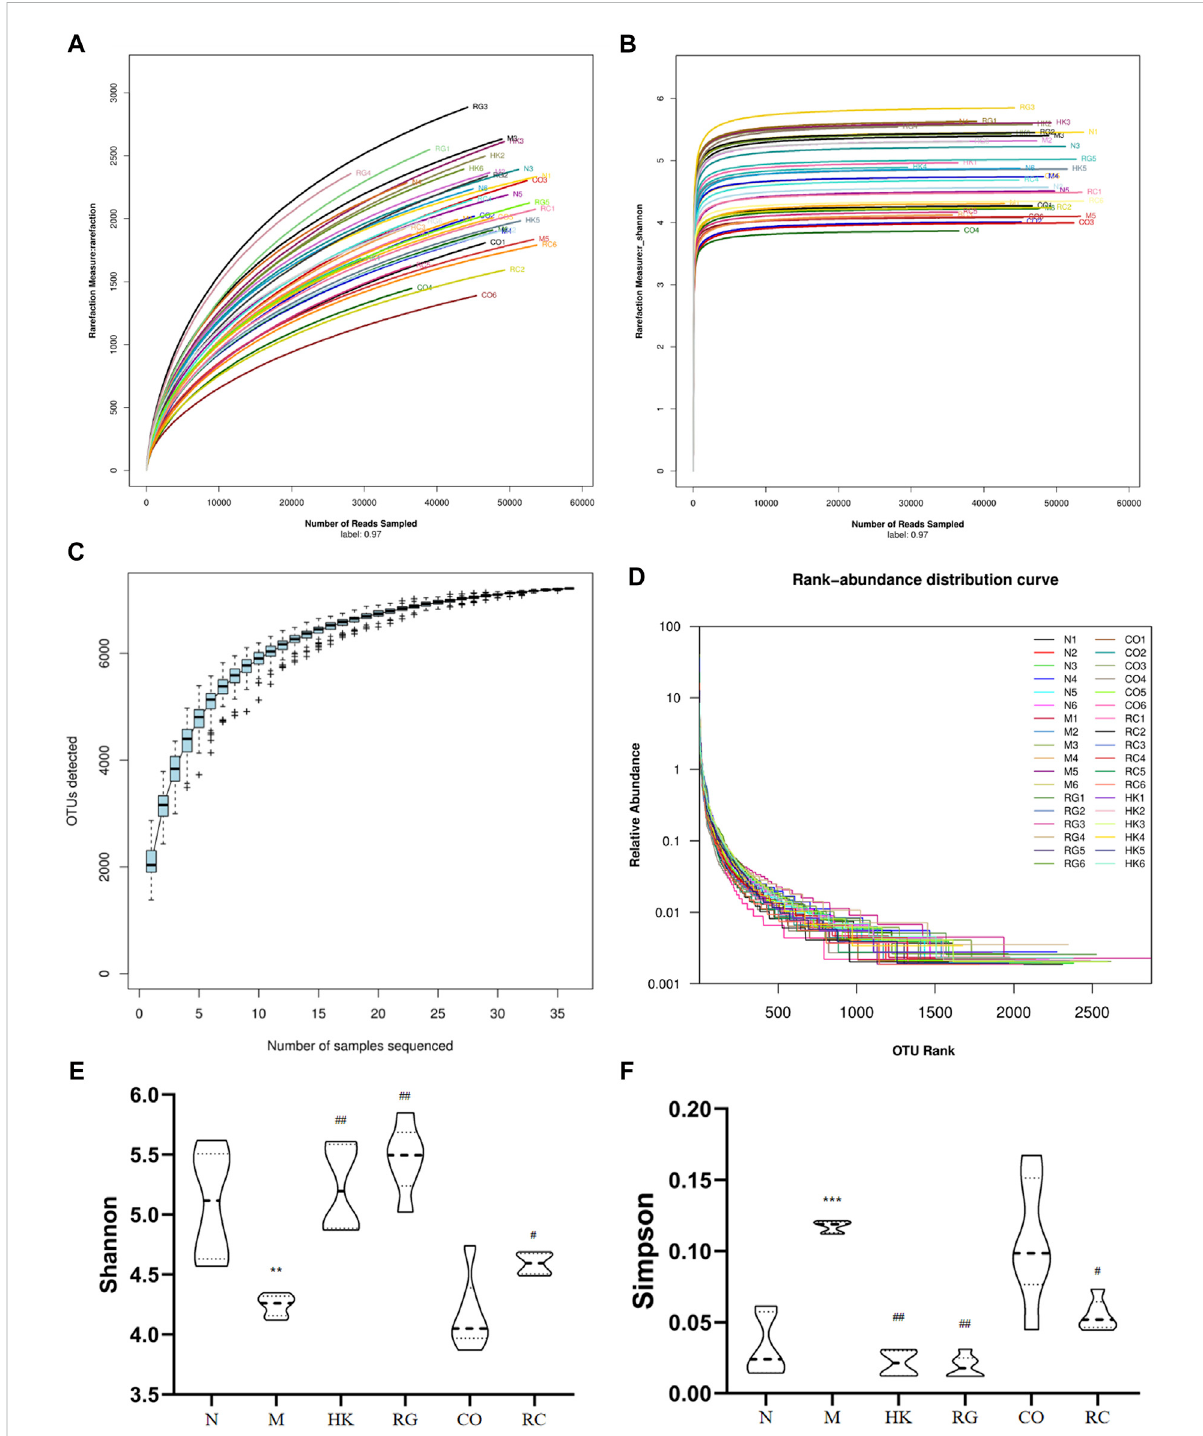
FIGURE 6 Changes in the microbial community diversity and structure. (A) Rarefaction curves, (B) Shannon – Wiener curves, (C) species accumulation curves, (D) rank-abundance distribution curve, (E) Shannon – Wiener curves, and (F) Simpson curves. (Data are means ± SD. ** p < 0.01 vs . normal group; ## p < 0.01 and # p < 0.05 vs . model group. n =